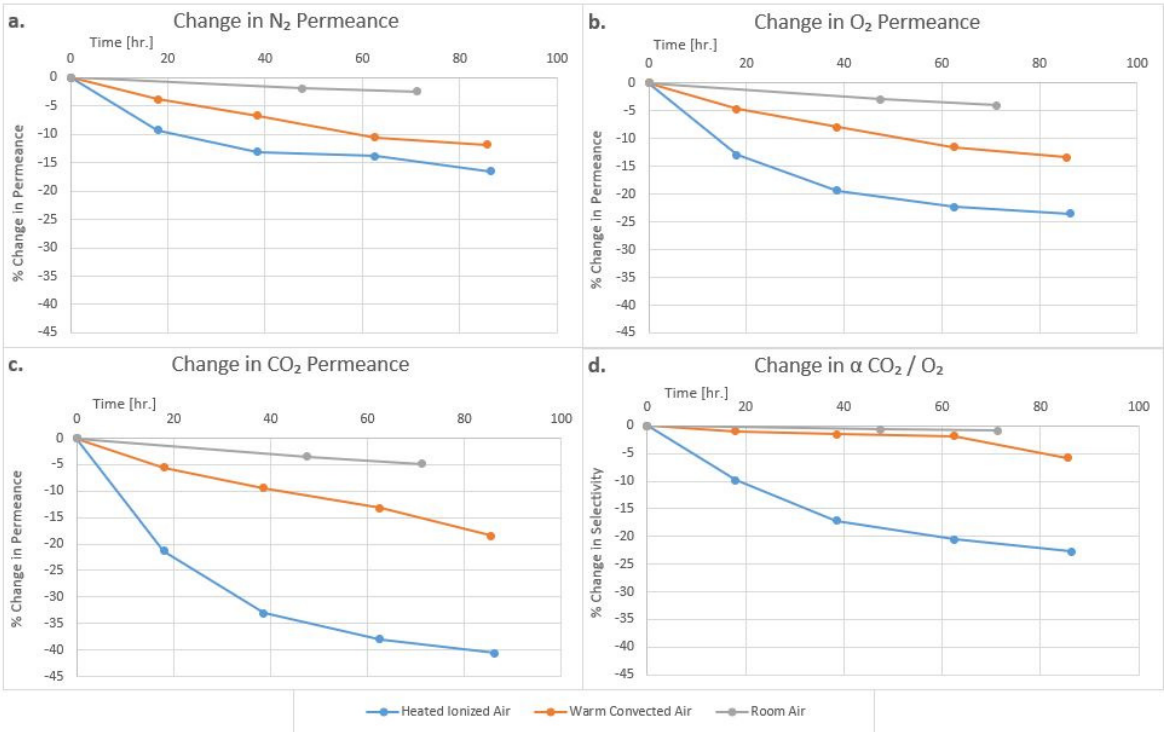
Figure 10. Effect of heated Ionized, warm convective air and room air on N 2 ( a ), O 2, ( b ) and CO 2 ( c ) gas permeance and CO 2 /O 2 selectivity ( d ) of TMCTS plasma polymer-based membrane.